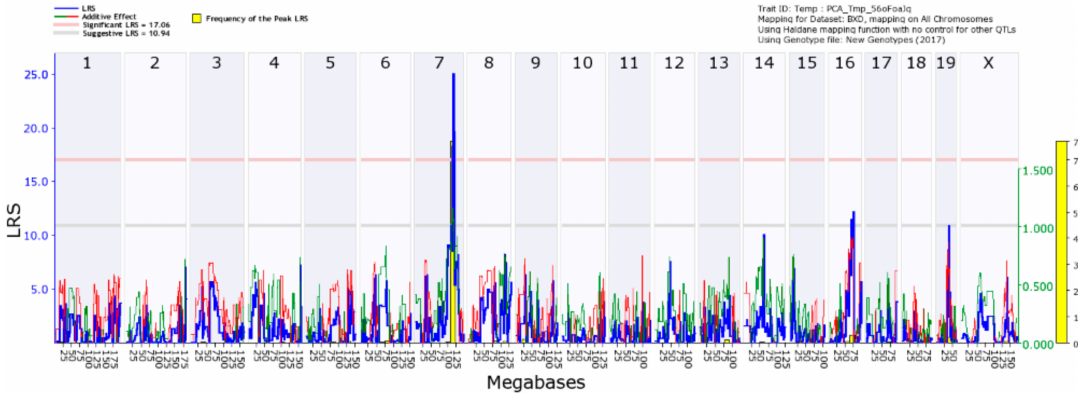
Figure 8. Quantitative trait locus map of Il1b expression change following 7 days of corticosterone in the drinking water and 6h following i.p. injection of diisopropylflurophosphate (4 mg / kg). The dependent variable (eigenvariable) is the first principal component derived from males and females individually and combined. Genome-wide interval mapping was performed using GeneNetwork software. The map shows a significant peak on chromosome 7 and two suggestive peaks, one on chromosome 16 and the other on chromosome 19. The latter two peaks lacked su ffi cient bootstrap support (yellow bars) and thus considered spurious.